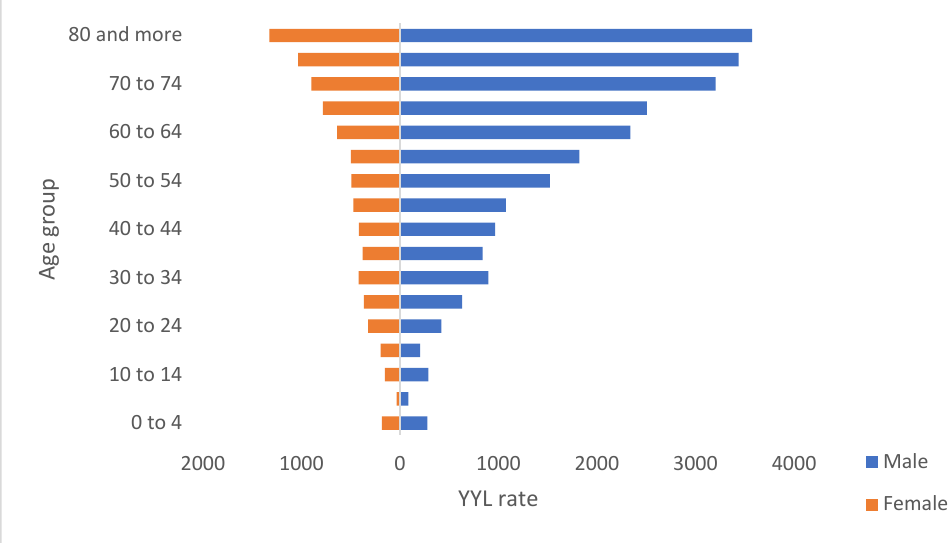
Figure 1. YYL rate by sex an age groups, Colombia, 2010–2018. When premature mortality was discriminated against at the subnational level, the territorial entities that stood out for presenting the highest rate during the study period were Amazonas (1561.1, IC 95% 996.7–2232.5), Risaralda (1167.6 IC 95% 891.4–1483.9), At-